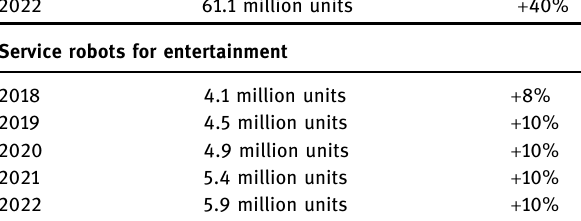
Figure 2: Number of multipurpose industrial robots per 1,000 people employed in the manufacturing sector ) , ILO, 2016 [ 11 ]